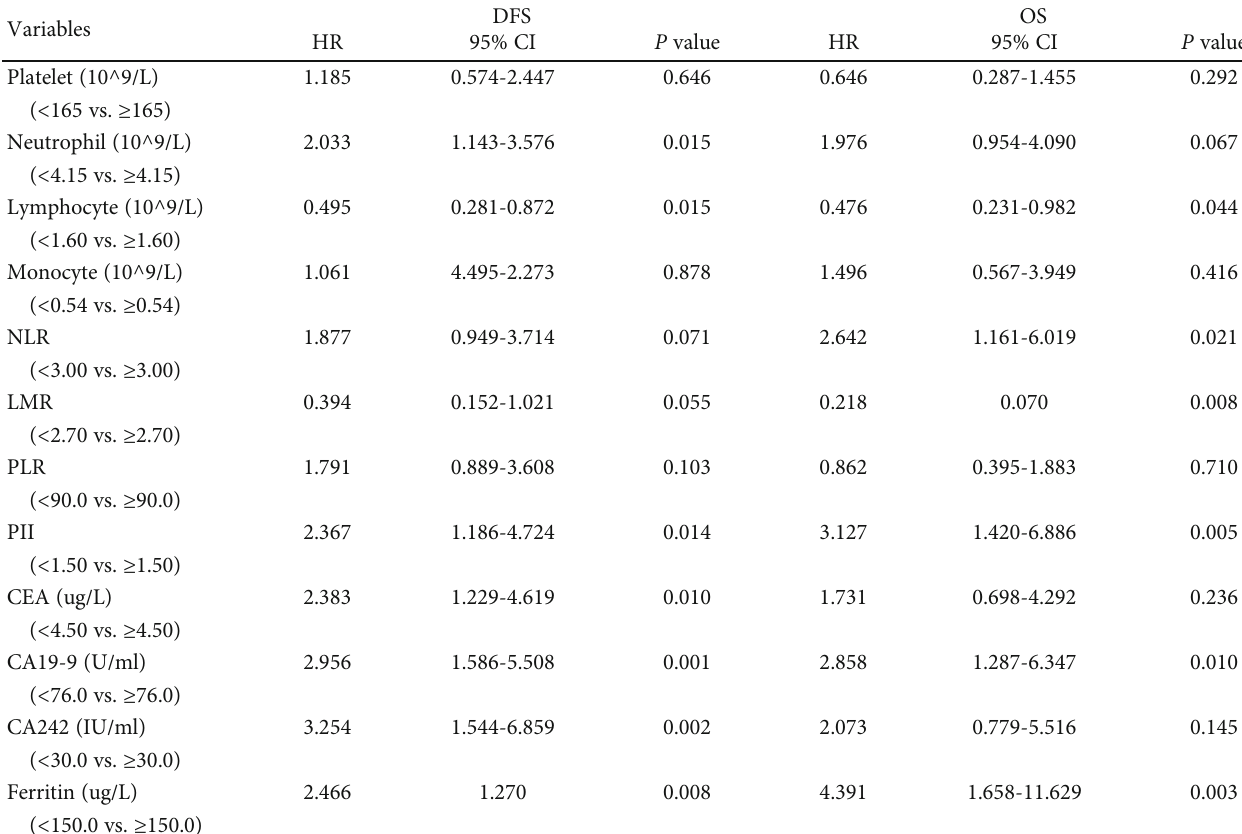
Table 3: Univariate analysis of prognostic factors for small-duct type ICC in the training